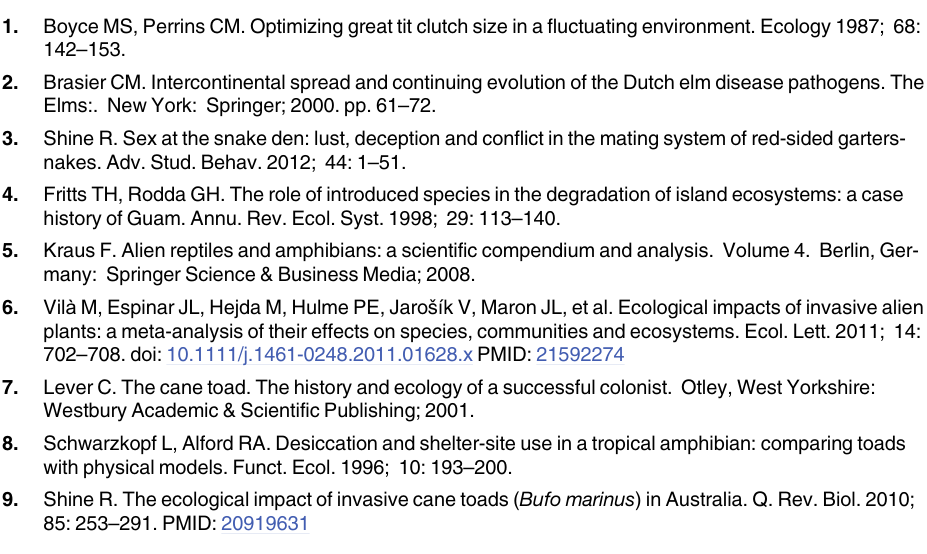
S1 Table. The data underlying this study has been made available in a table of supporting